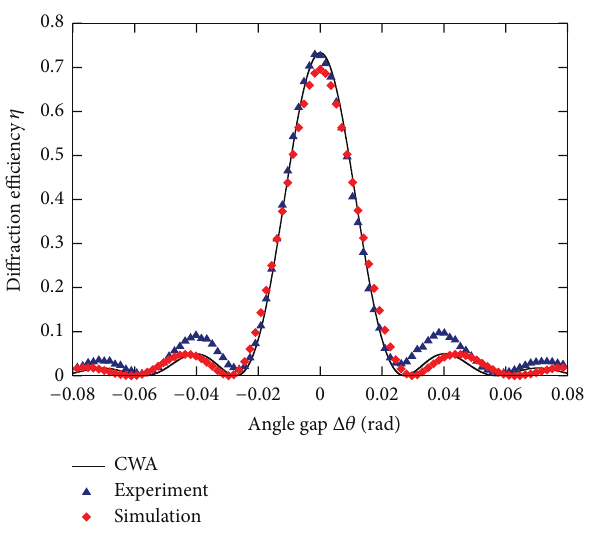
Figure 8: Time variation of the